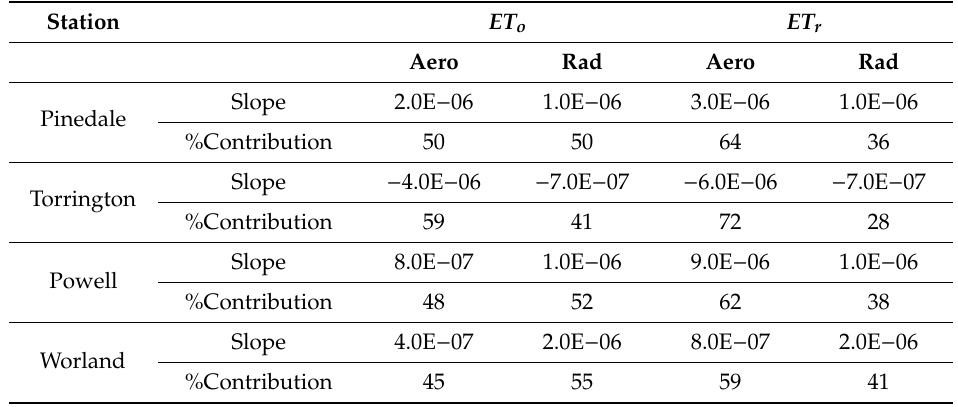
Table 7. Average percent contribution and slope of trend analysis for the aerodynamic and radiative components of ET o and ET r at Pinedale, Torrington, Powell, and Worland, WY. Station ET o ET r Aero Rad Aero Rad Slope Pinedale